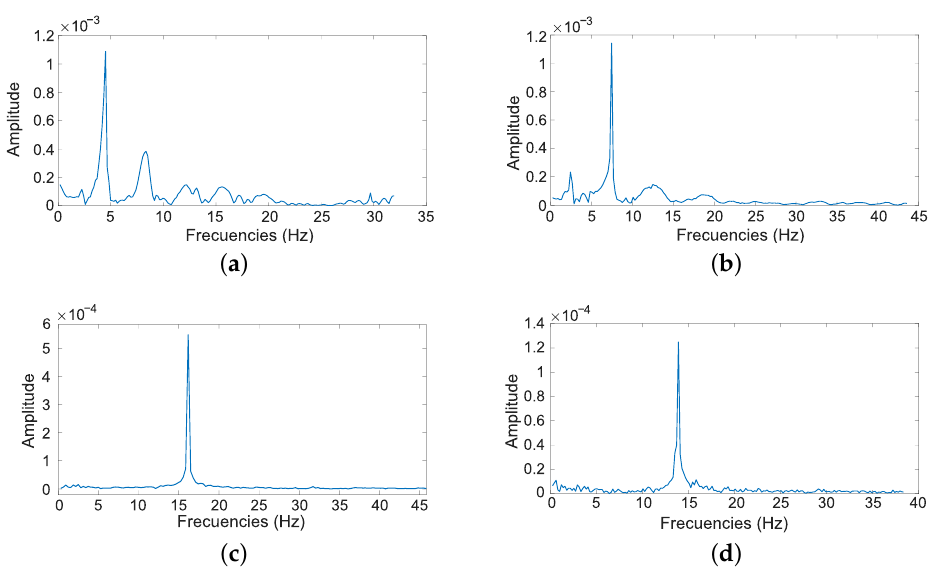
Figure 19. Experimental results obtained after processing Γ c y : ( a ) contact point 0.3 m, ( b ) contact point 0.5 m, ( c ) contact point 0.8 m and ( d ) contact point 0.9